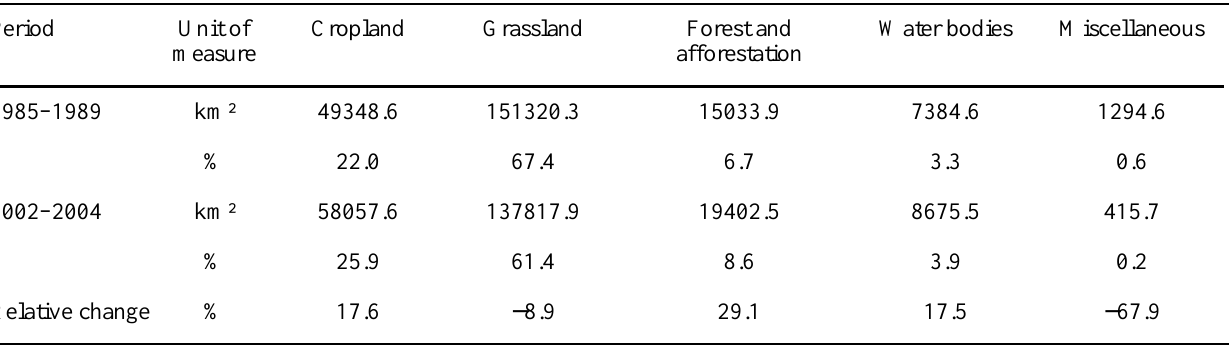
Table 2. Area of each of five land-use and land cover types for the entire study region in two periods and the relative change in area between the two